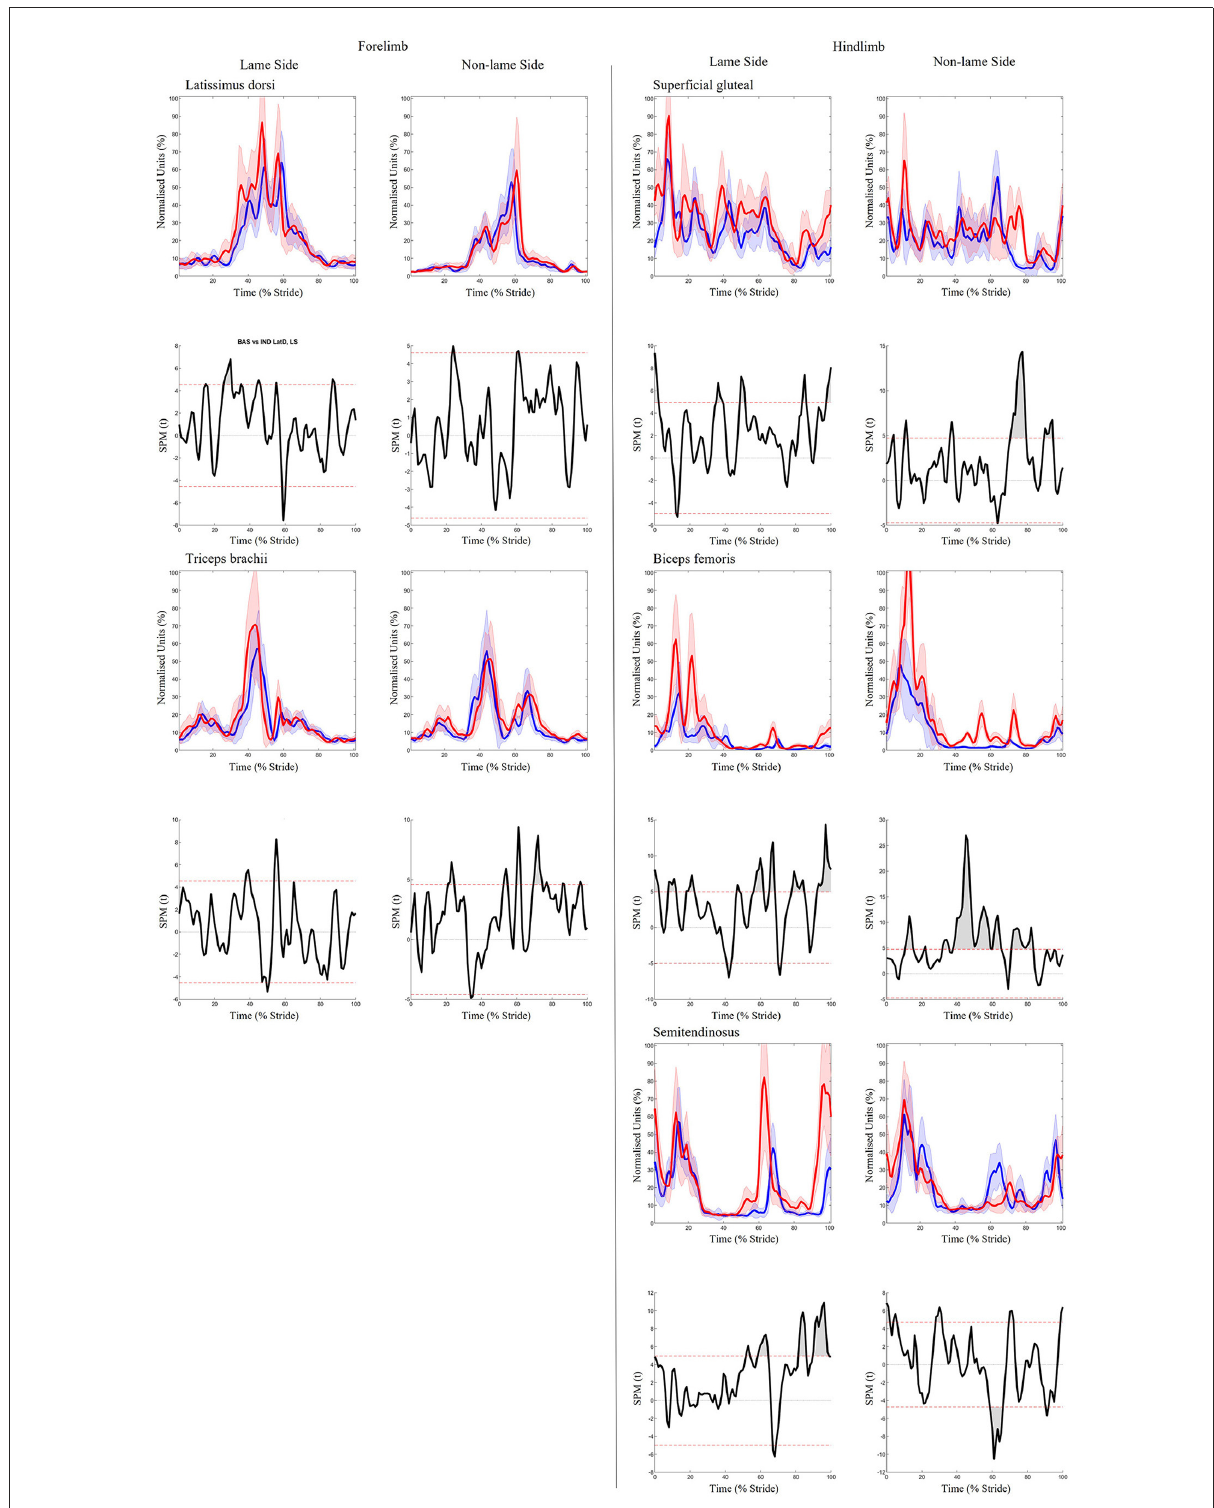
FIGURE6 SPM results for time- and amplitude-normalized sEMG data from a representative “horse 7” ( n = 1) for studied superficial muscles of the forelimb (Left panel) and hindlimb (Right panel) during baseline 1 (blue solid lines/shaded area) and induced hindlimb lameness (red